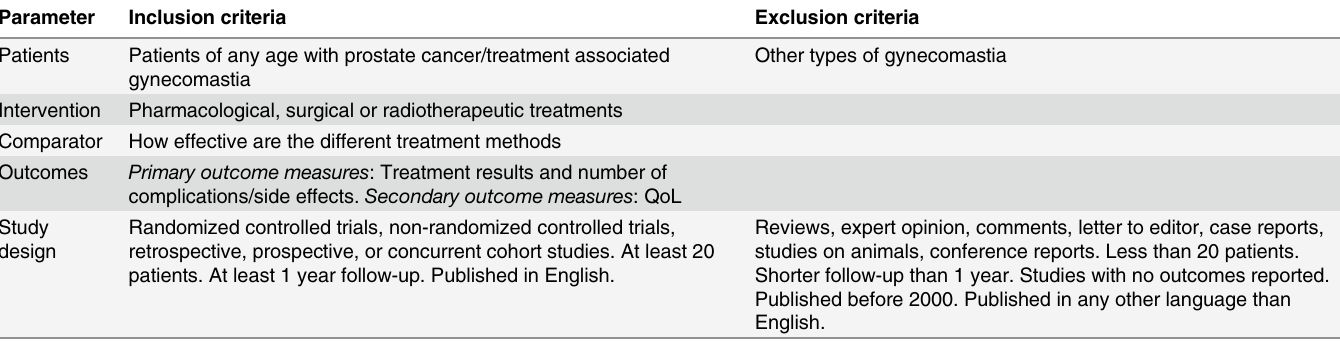
Table 1. PICOS criteria for inclusion and exclusion of